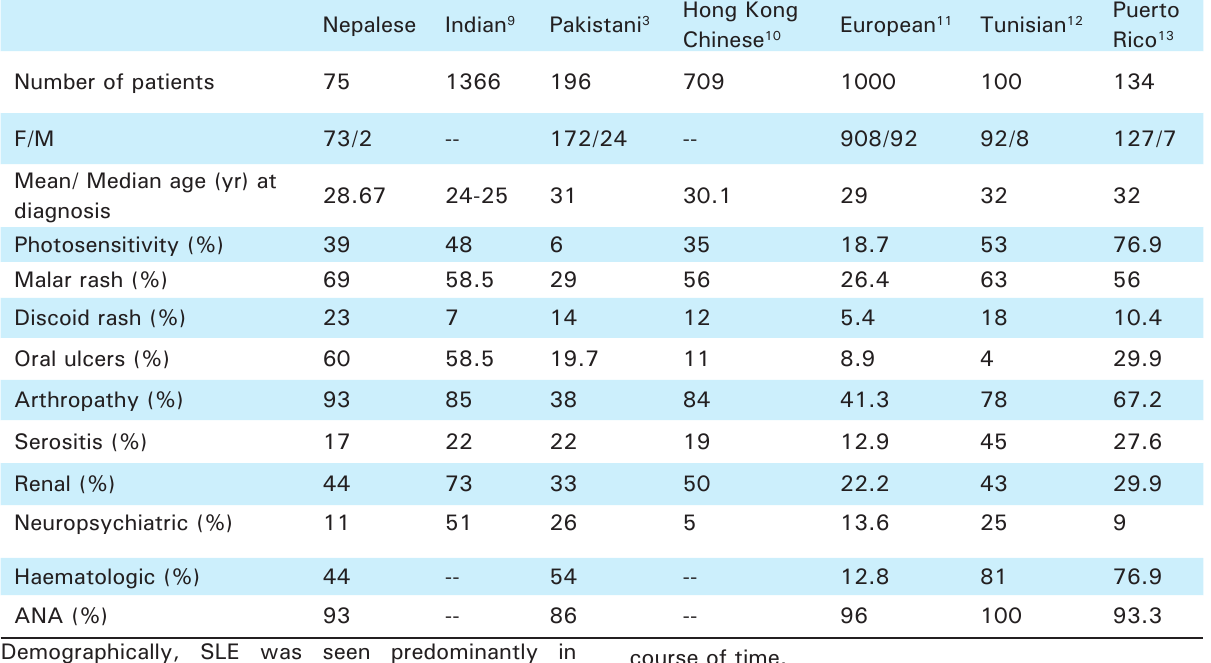
Table 3 . Comparison of clinical manifestations and ANA profile of SLE patients between Nepalese and other